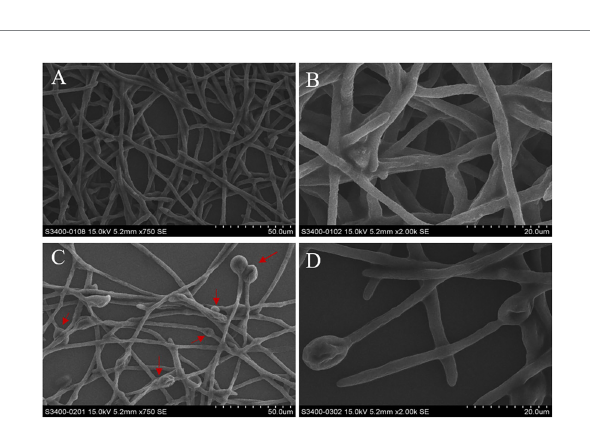
FIGURE 4 Micromorphology of mycelia from 48 h old cultures of F. graminearum under scanning electron microscopy at 750× and 2,000× magnification. Mycelial structure of F. graminearum . (A,B) In the absence of methanol extract treatment. (C,D) In the presence of treatment with crude methanol extract (100 μ g/ml). The red arrows indicate areas of swelling.